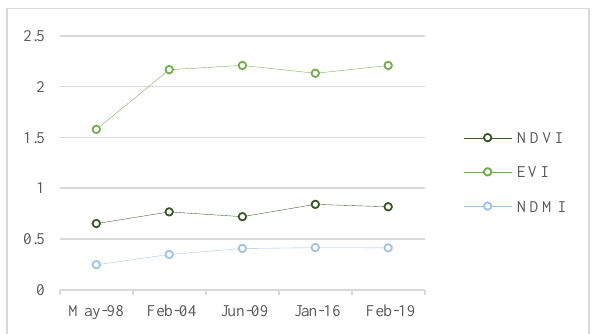
Figure 4. Trends of Vegetation Indices from 1998 to 2019 Likewise, the values of EVI show an increasing trend from 1998 to 2019. The highest EVI value was also in 2016 at 2.1, while the lowest was in 1998 at 1.57.